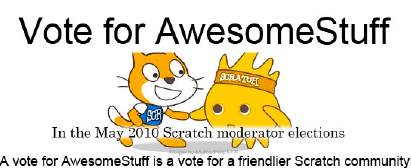
Figure 11. A campaign image created by a Scratch member to promote his community moderator Figure nomination.